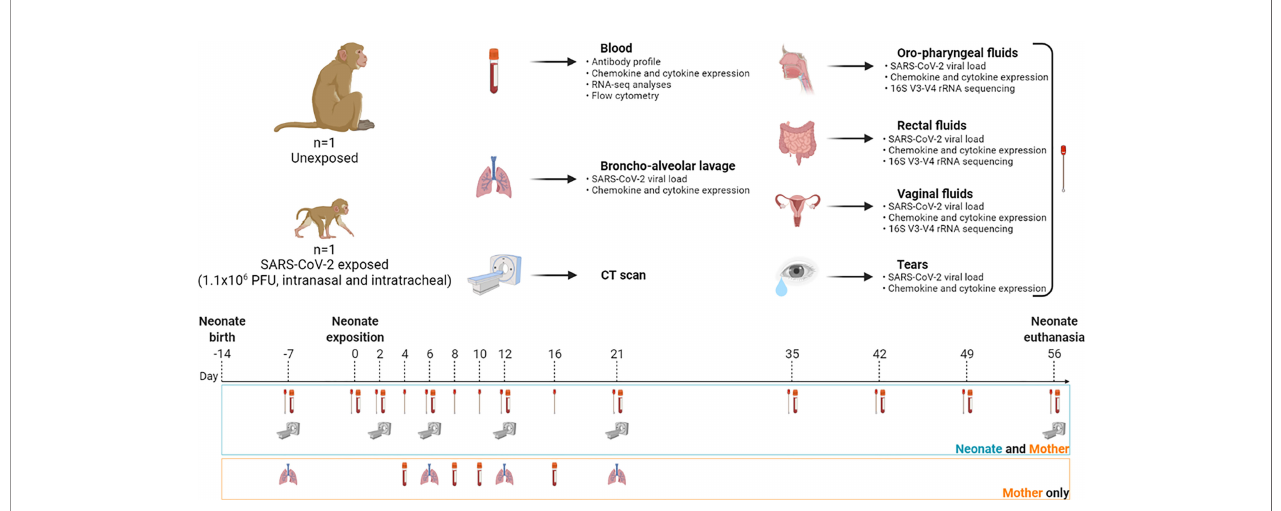
FIGURE 1 | Study design and work fl ow. A female rhesus macaque neonate was exposed at 14 days of life to a total dose of 1.1 × 10 6 PFU of SARS-CoV-2 by the intranasal and intratracheal routes. Symbols: blood tube for bleeding; lungs for bronchoalveolar lavage; scan machine for CT session; swab for biological fl uid collection (nasal, oropharyngeal, vaginal, rectal, and tears). Samples were collected at day postinfection (DPI) − 7, 0, 2, 4, 6, 8, 10, 12, 16, 21, 35, 42, 49, and 56. Analysis of peripheral blood and fl uids included viral RNA load kinetics and chemokine/cytokine quanti fi cation. Microbiota identi fi cation was done in every fl uid compartment. Antibody pro fi ling, RNA-seq analyses, and fl ow cytometry were also performed in blood. Created with